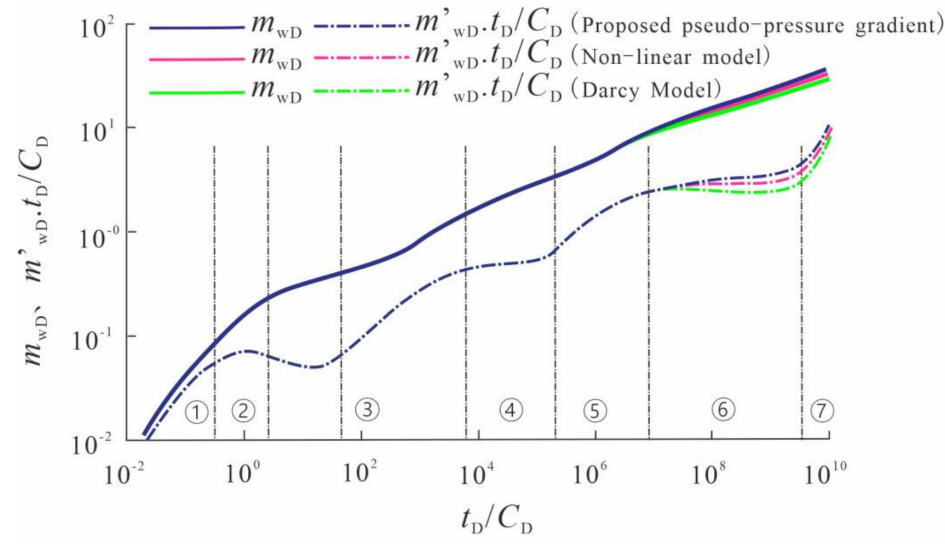
Figure 3. Comparison of dynamic pseudo pressure curves of different models.